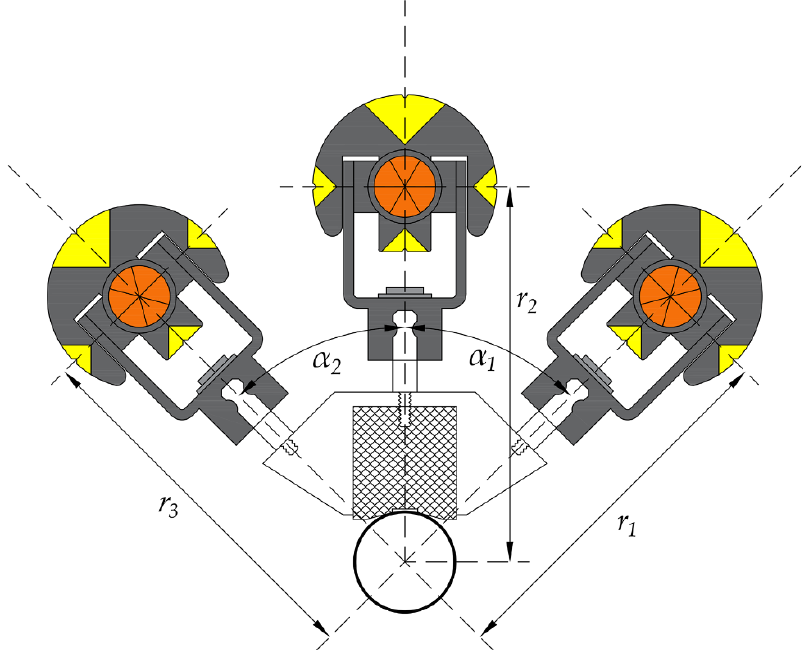
Figure 4. The design of the new multi-prism platform — magnetic base for fixing the platform to the metal tube (hatch fill), the connecting element with prism adapters and the three mini prisms. The geometry of the platform is accurately defined by three distances from the tube center ( 𝑟 1 , 𝑟 2 , and 𝑟 3 ) and two central angles ( 𝛼 1 and 𝛼 2 ).